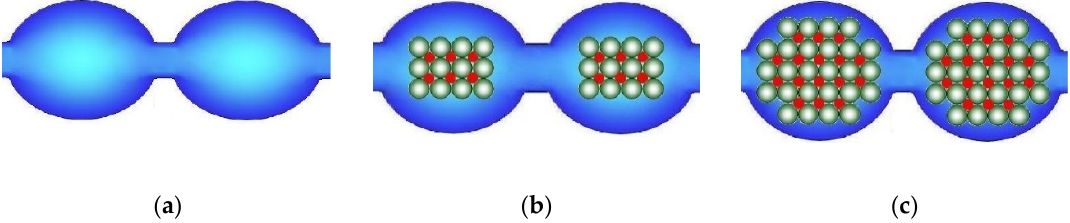
Figure 6. Scheme of the pore structure change: the initial membrane ( a ) and membranes modified with nanoparticles of different sizes ( b , c ) according to the case of the model of limited elasticity of the pore walls (redrawn from [206]).